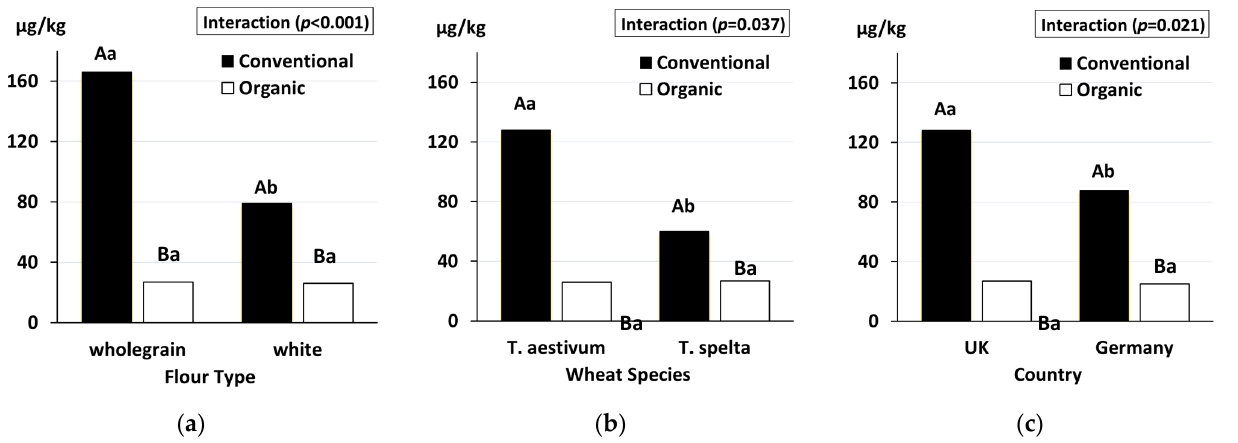
Figure 8. Effect of organic and conventional production methods on the total pesticide residue concentrations in ( a ) whole-grain and white/refined wheat flour, ( b ) spelt and common wheat flour and ( c ) wheat flour samples produced in the UK and Germany). Data from [140]. Means/bars for the same production system (=same color) labelled with the same lower-case letter and means/bars for the same flour types, wheat species or country labeled with the same capital letters are not significant different ( p < 0.05).